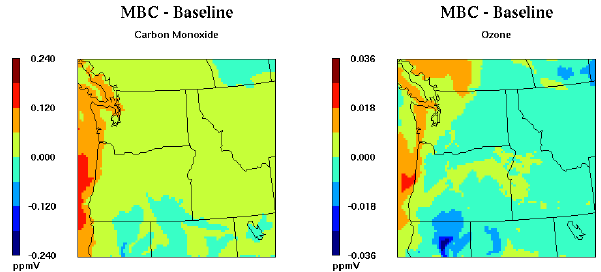
Fig. 13. Change in AIRPACT-3’s predicted surface concentrations of carbon monoxide (left) and ozone (right) for the peak ozone hour (17 August 2010). Warm colors denote larger concentrations in the dynamic boundary conditions simulation (MBC) while cooler col- ors denote larger concentrations in the original AIRPACT-3 simula- tions (baseline).